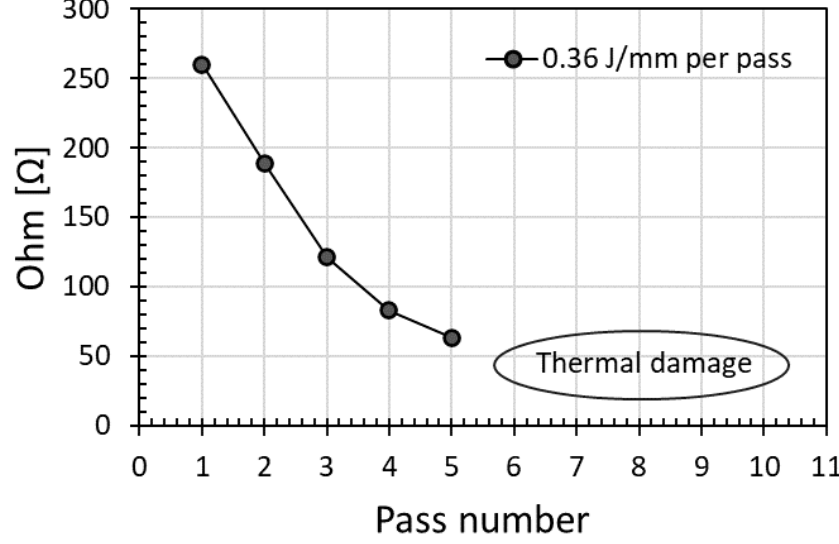
Figure 4. Effect of scanning pass number on electrical resistance at a laser power of 18 W and a scanning speed of 50 mm/s (which produced an energy dose per unit length of 0.36 J/mm per